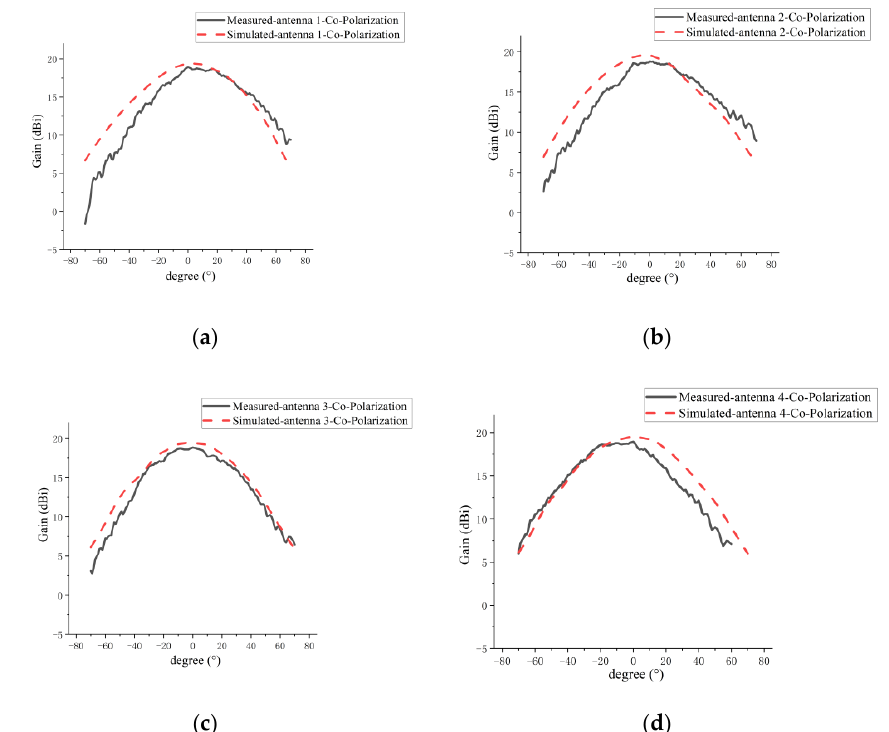
Figure 24. Comparison of measured and simulated E-plane co-polarization patterns for every antenna element in sparse array: ( a ) grid antenna 1; ( b ) grid antenna 2; ( c ) grid antenna 3; ( d ) grid antenna 4.